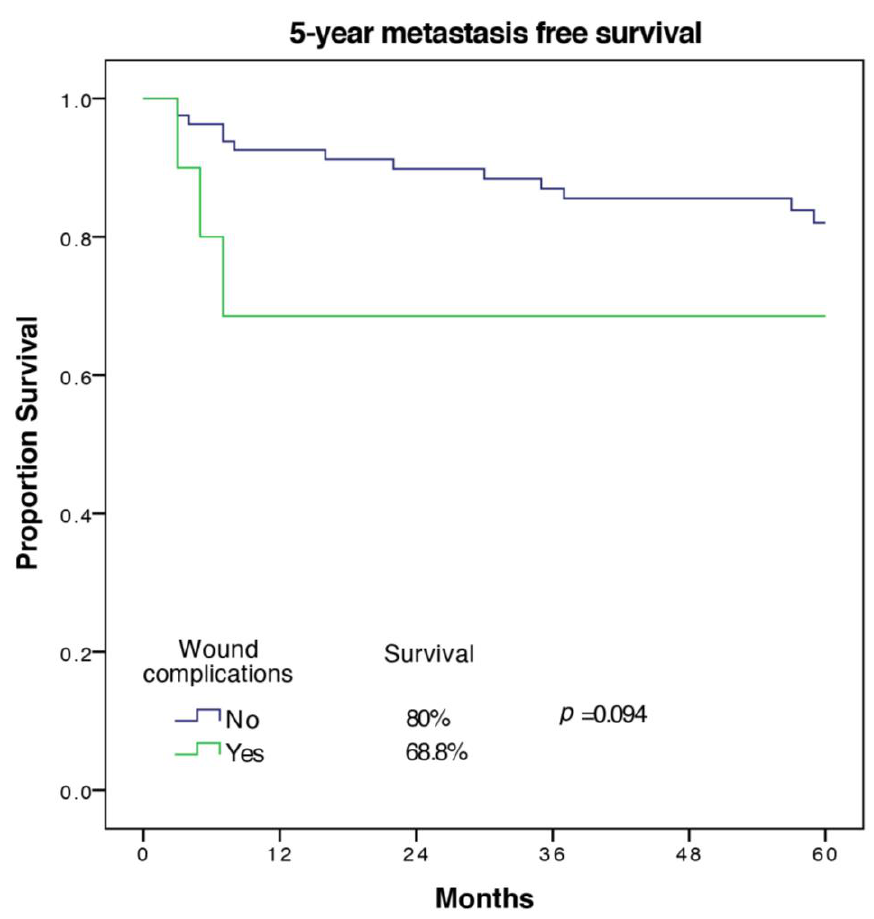
Figure 2. 5-year metastasis free survival of patients with and without wound complications.